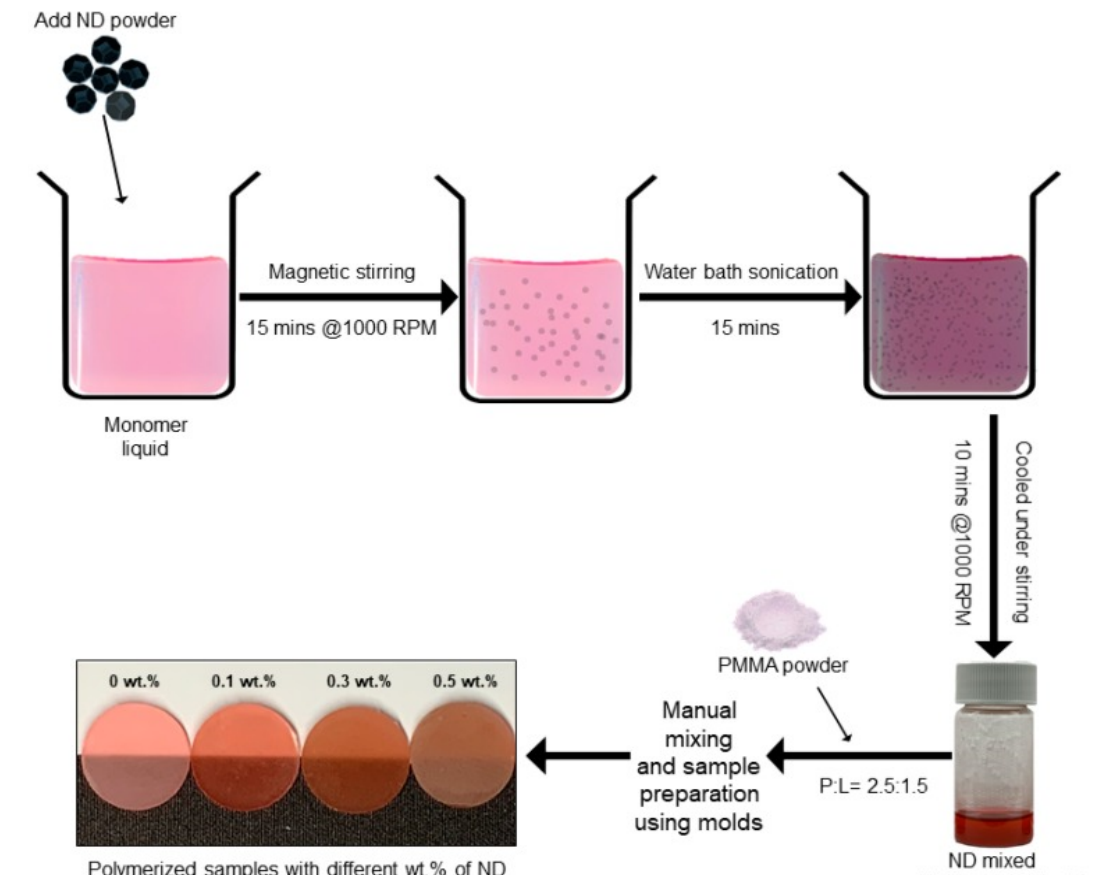
Figure 9. Representation of the preparation of PMMA/ND nanocomposites. Reprinted from ref. [112], copyright 2019, MDPI.